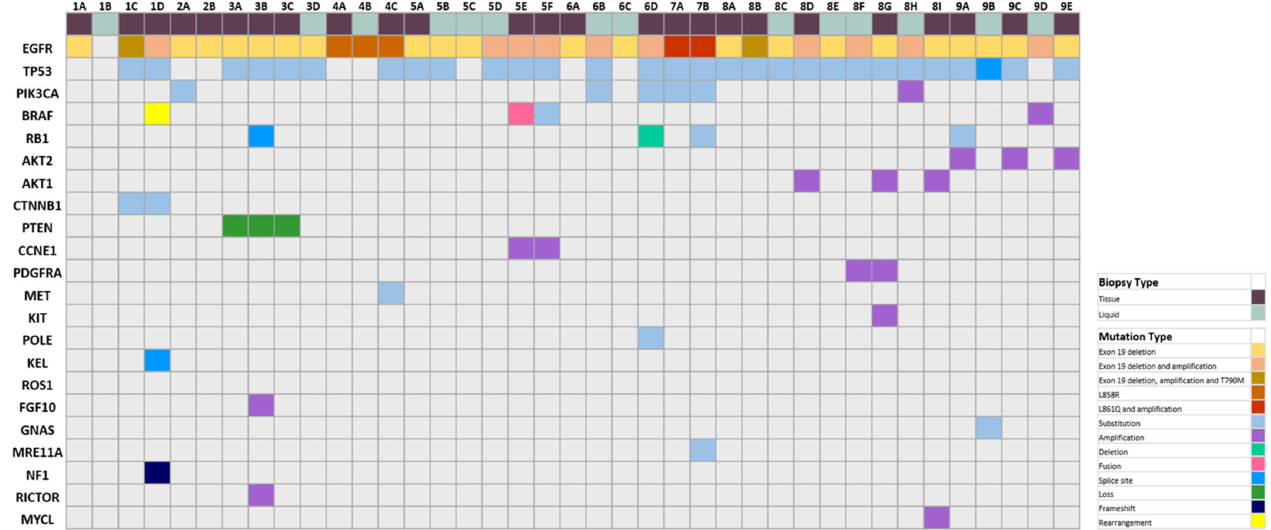
Figure 2. Mutational profile of EGFR NSCLC to neuroendocrine-transformed patients with multiple time points. NGS mutation results from both tissue and liquid biopsy were classified according to mutation subtypes, including EGFR exon 19 deletion; exon 19 deletion and amplification; exon 19 deletion, amplification, and T790M; L858R; L861Q and amplification; and other mutational subtypes, including substitution; amplification; deletion; fusion; splice site; loss; frameshift; rearrangement. The time points of the different molecular testing results are denoted by letters A-I for each patient in sequential order that they were performed.